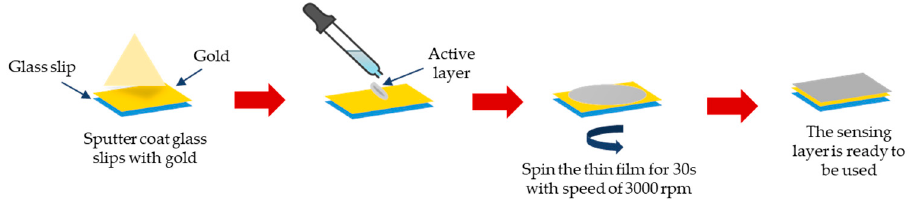
Figure 2. Steps involved in thin film preparation process.